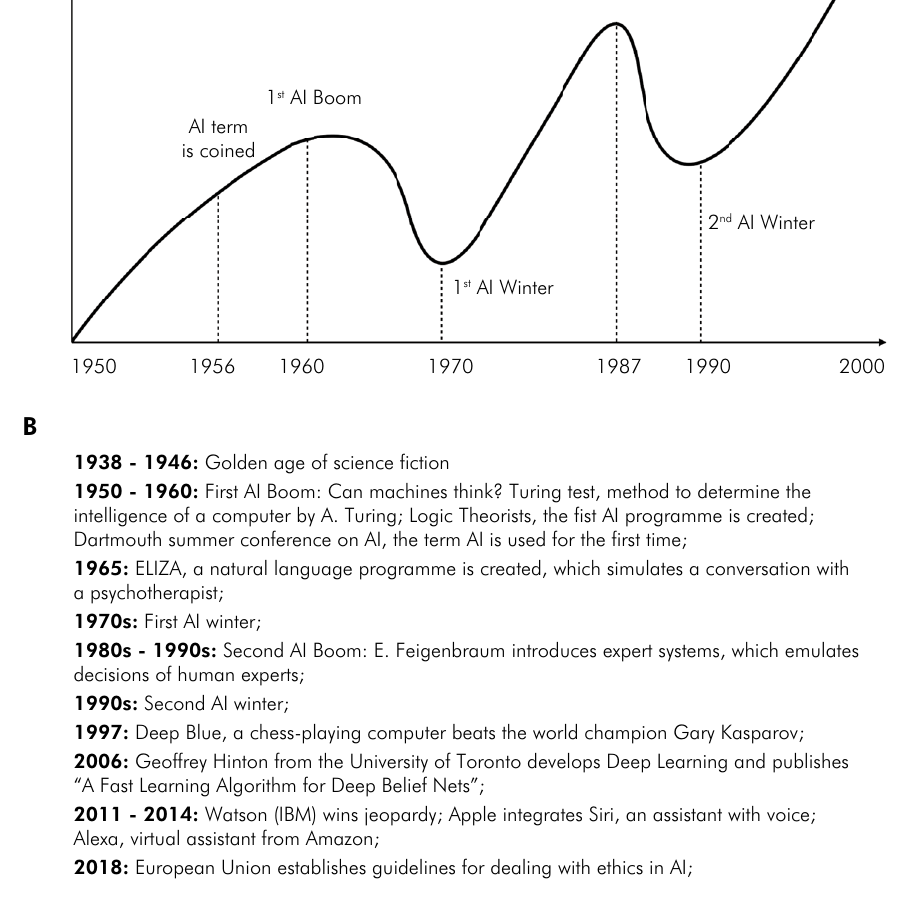
Figure 1. Timeline illustration of AI